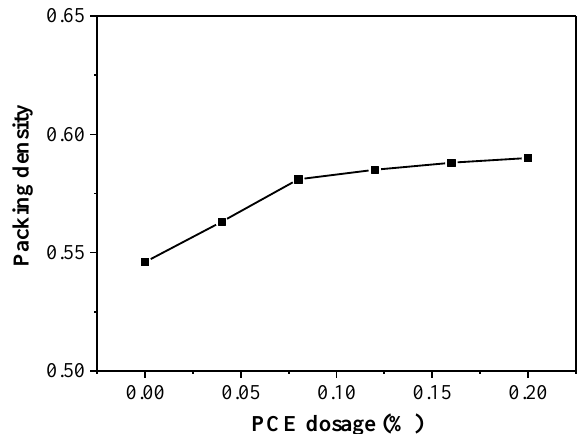
Figure 4. Packing density versus the PCE dosage for fresh cement paste.